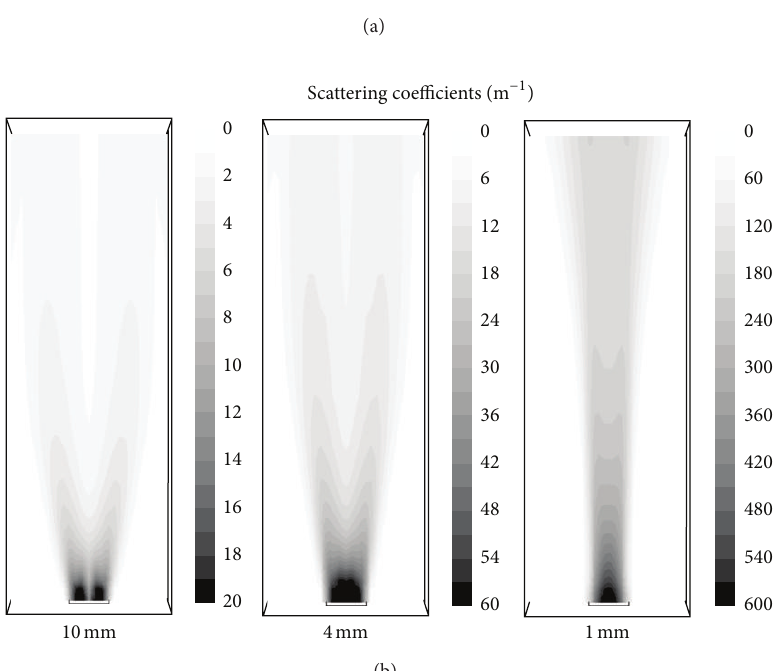
Figure 8: Variations in the bubble volume fractions (a) and scattering coefficients (in m −1 ) (b) as a function of the bubble diameter in the TFM